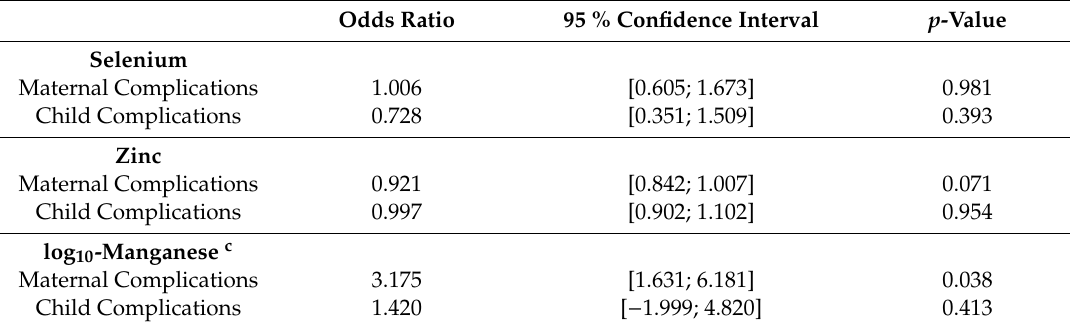
Table 4. Association of selenium, zinc, and manganese in blood serum of pregnant women with the risk of maternal and child complications a,b